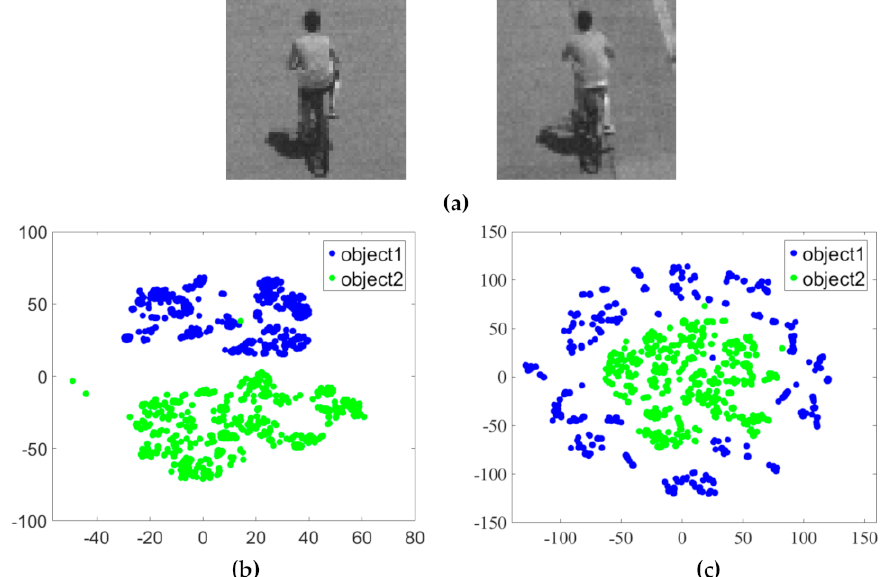
Figure 7. The scatter-plot visualization representations of the HSI and RGB datasets with the challenge of background clutter using t-SNE. ( a ) Sample images of the dataset with background clutter (from left to right: object1 and object2). The two objects are similar in visual appearance. ( b ) Visualization of the HSI dataset. ( c ) Visualization of the RGB dataset. The x axis and y axis represent the two feature values of the data in two-dimensional space, respectively. There are two kinds of objects in two data sets, each of which is represented by a particular